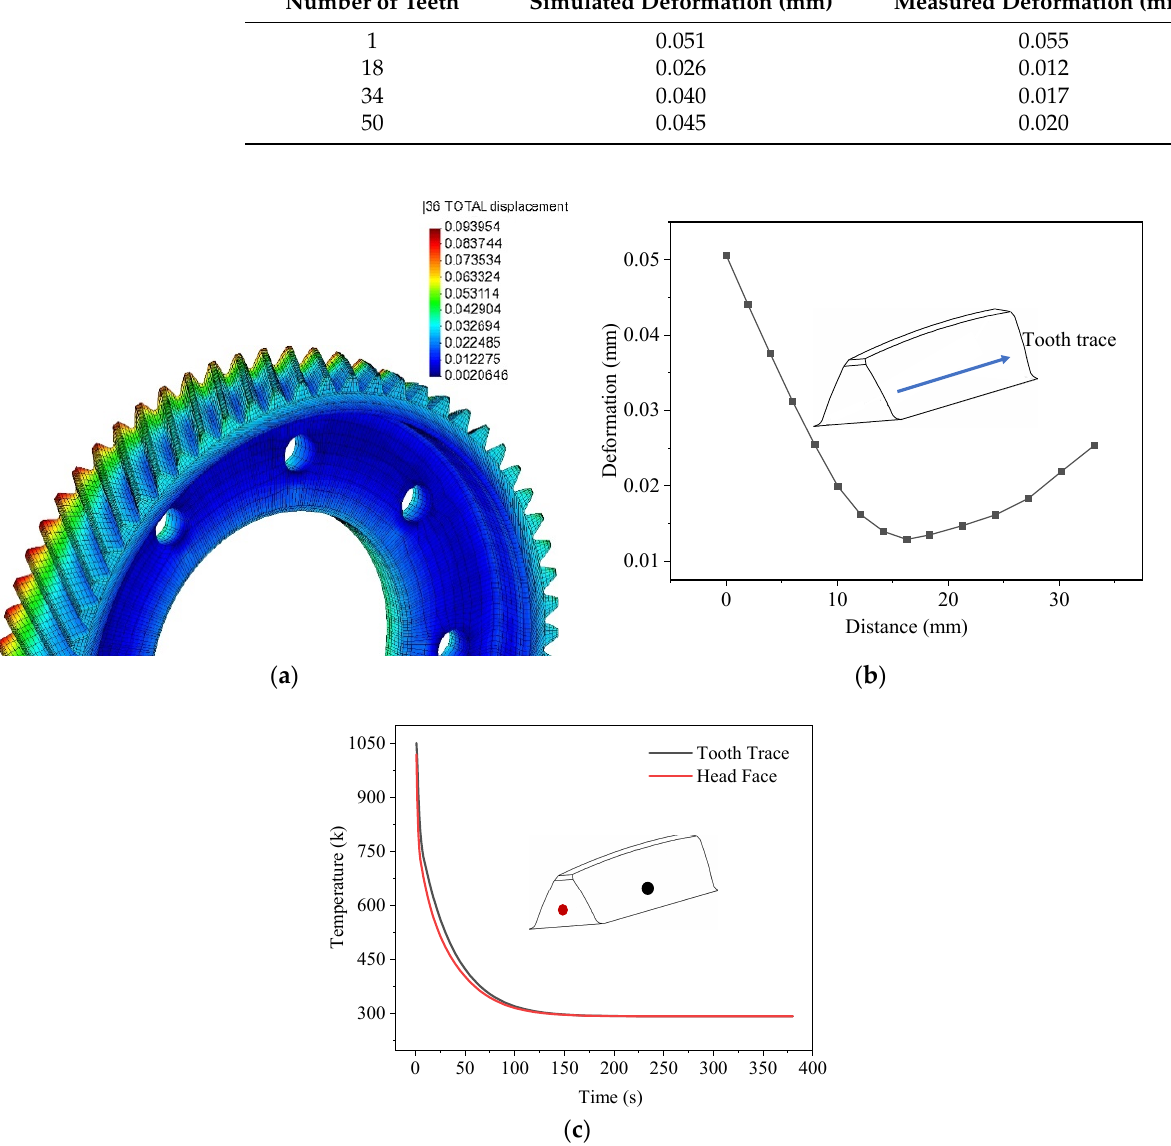
Table 2. Measured and simulated surface deformation value contrast.